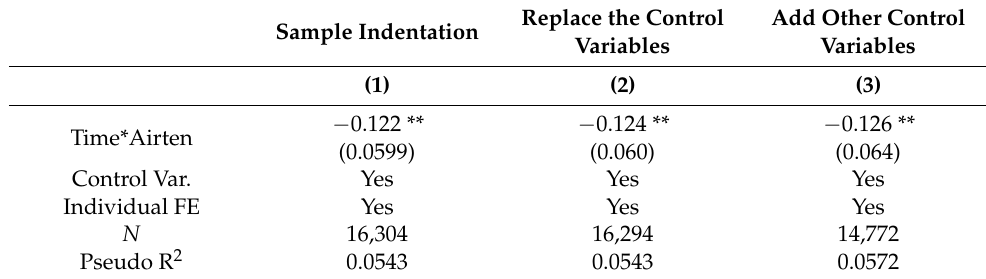
Table 9. Ordinal logistic regression results of further robustness test.